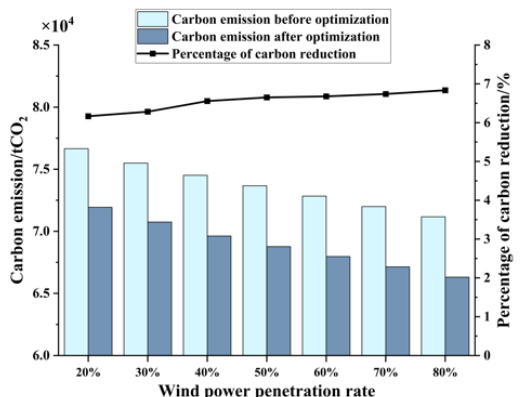
Figure 13. The carbon emissions and carbon reduction percentages before and after the optimization in different wind power penetration